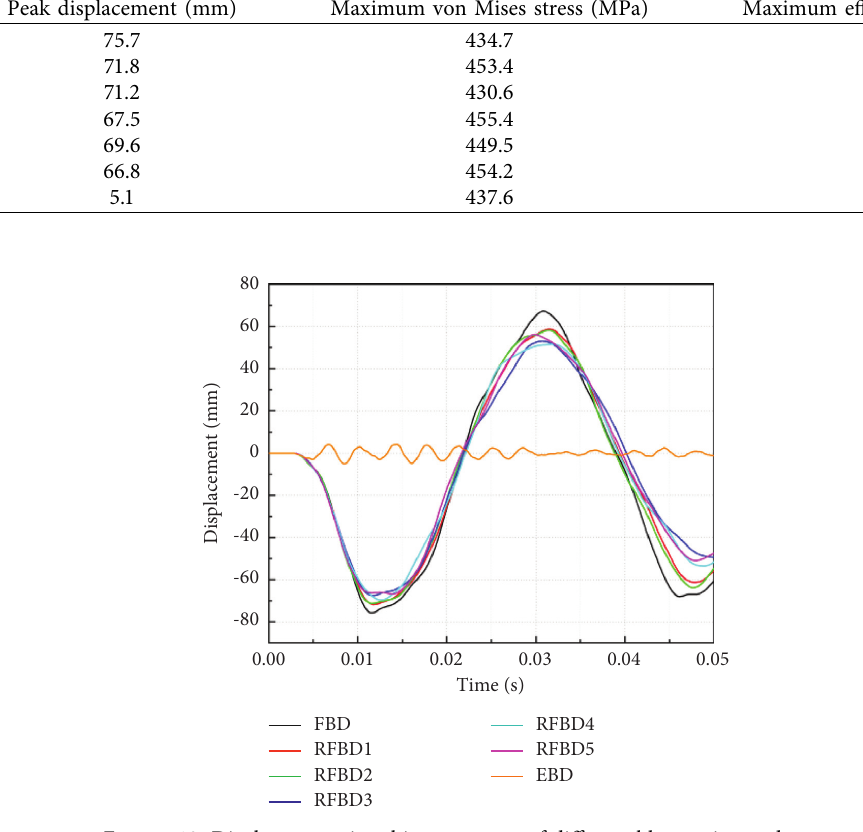
Figure 10: Displacement time history curves of different blast-resistant doors.